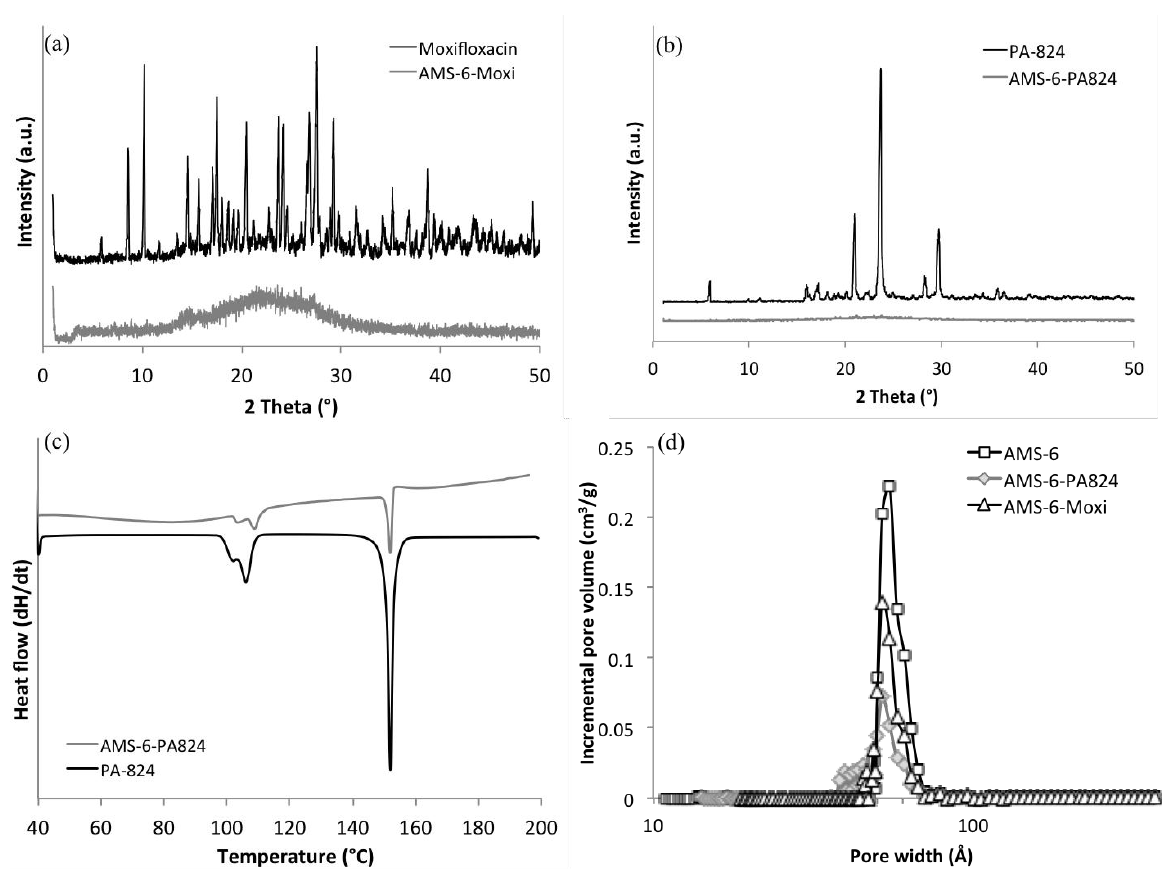
Figure 2. X-ray diffraction patterns of ( a ) free moxifloxacin, and AMS-6-Moxi; ( b ) free PA-824, and AMS-6-PA824. Both show that the free drug in its crystalline state and the encapsulated material contains drug in the amorphous state; ( c ) differential scanning calorimetry (DSC) curves of free and loaded PA-824; ( d ) pore size distribution of